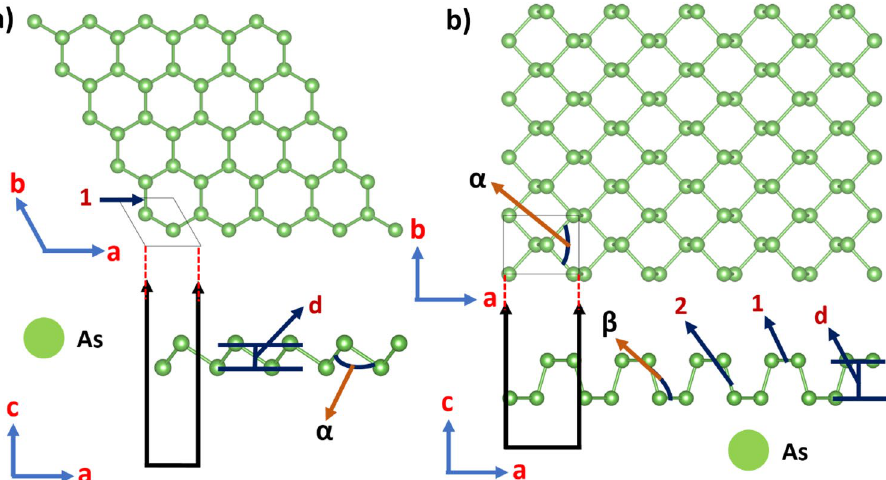
Figure 3. ( a ) Top and side views of buckled arsenene, ( b ) Top and side views of puckered arsenene. 1 and 2 correspond to the bond lengths, α and β correspond to bond angles of Table 1. Figure generated by using the